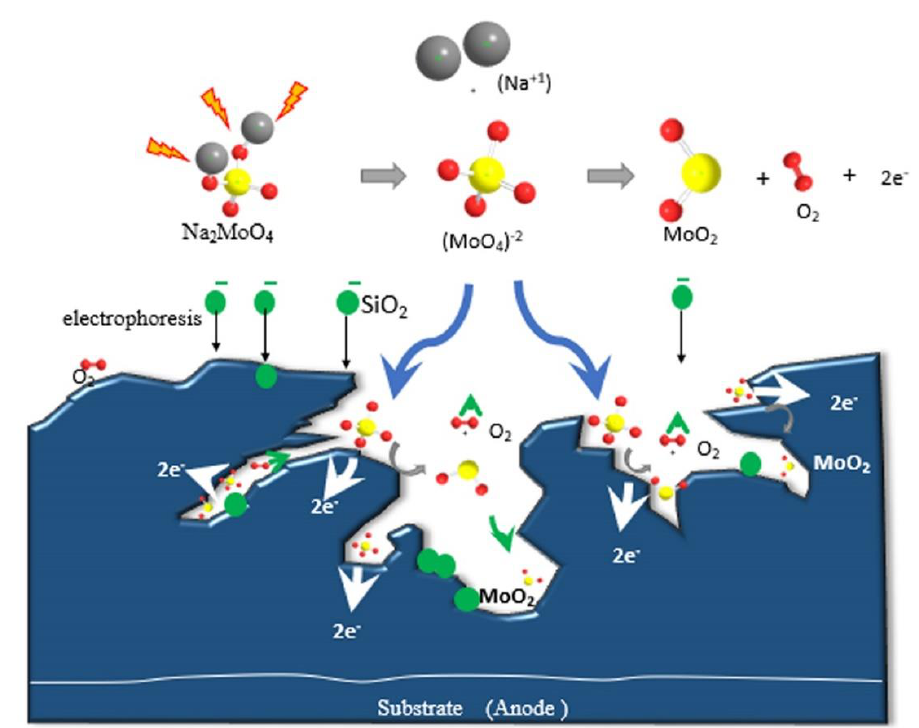
Figure 6. Schematic illustration underlying the incorporation mechanism of MoO 2 and SiO 2 phases into the TiO 2 layer. To explore the corrosion behavior of the coatings obtained in Baths A and B, PDP curves for the substrate and PEO coatings obtained in Baths A and B are presented in Figure 7. The obtained electrochemical parameters, such as corrosion potential ( E corr